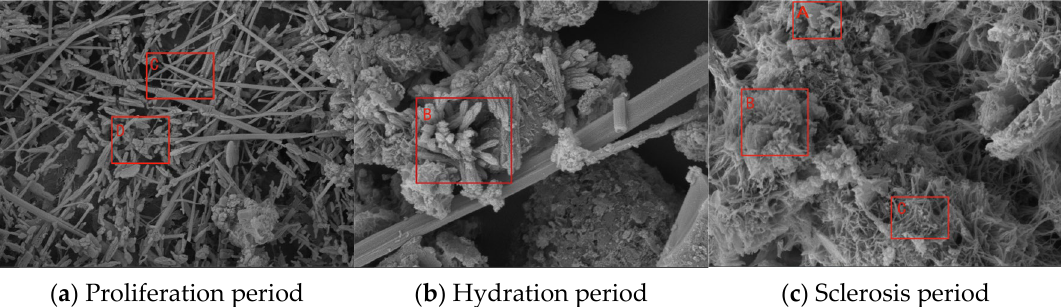
Figure 11. Shape of CFTFM hydration products.